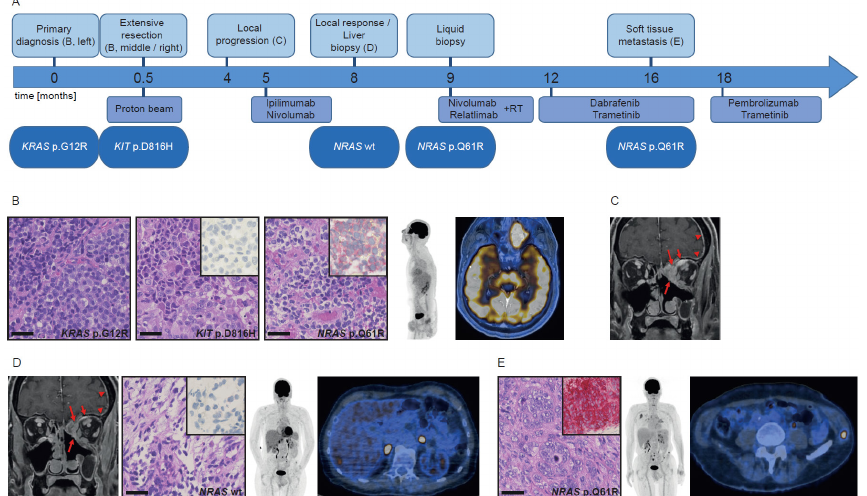
Figure 1. Course of disease, treatment, and morpho-molecular workup of patient 1. ( A ) Timeline. ( B ) Histology of the primary tumor, including NRAS Q61R immunohistochemistry (inserts); left: KRAS mutant region, middle: KIT mutant region, right: NRAS mutant region; PET MIP display and fused PET/CT image at primary diagnosis. ( C ) T1-weighted contrast-enhanced and fat-suppressed MR image at local progression (long arrows: sinonasal tumor mass, short arrows: intraorbital extraconal tumor mass, arrowheads: dural enhancement. ( D ) MR image at local regression (arrows/arrowheads: see above), histology of the liver biopsy, including NRAS Q61R immunohistochemistry (insert); PET MIP display and fused PET/CT image before liver biopsy. ( E ) Histology of the soft tissue metastasis, including NRAS Q61R immunohistochemistry (insert); PET MIP display and fused PET/CT image at progression under kinase inhibitors. Scale bar: 40 µ m. wt: wild type.